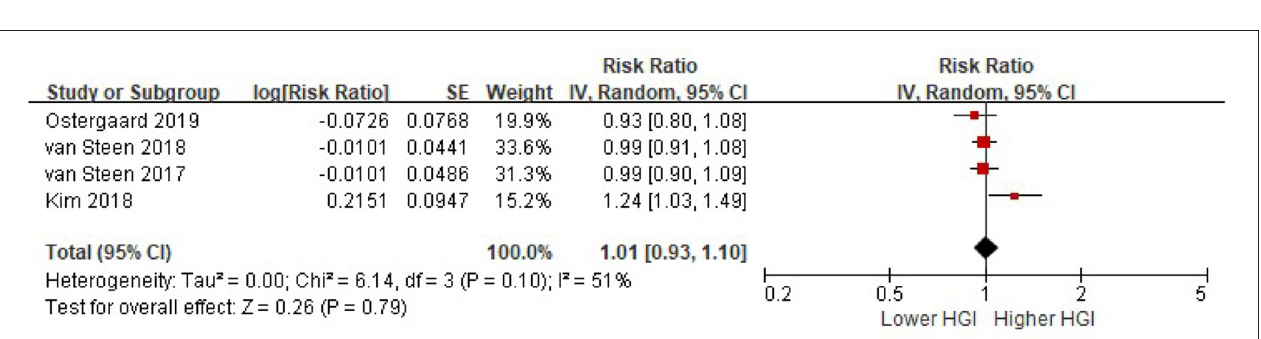
FIGURE 4 | The association between HGI and the risk of composite CVD further adjusting for HbA1c. Data were presented as the HR and 95% CI of composite CVD for per 1 SD increment of HGI, after adjusting for multiple cardiovascular risk factors and plus HbA1c. CI, confidence interval; CVD, cardiovascular disease; HGI, hemoglobin glycation